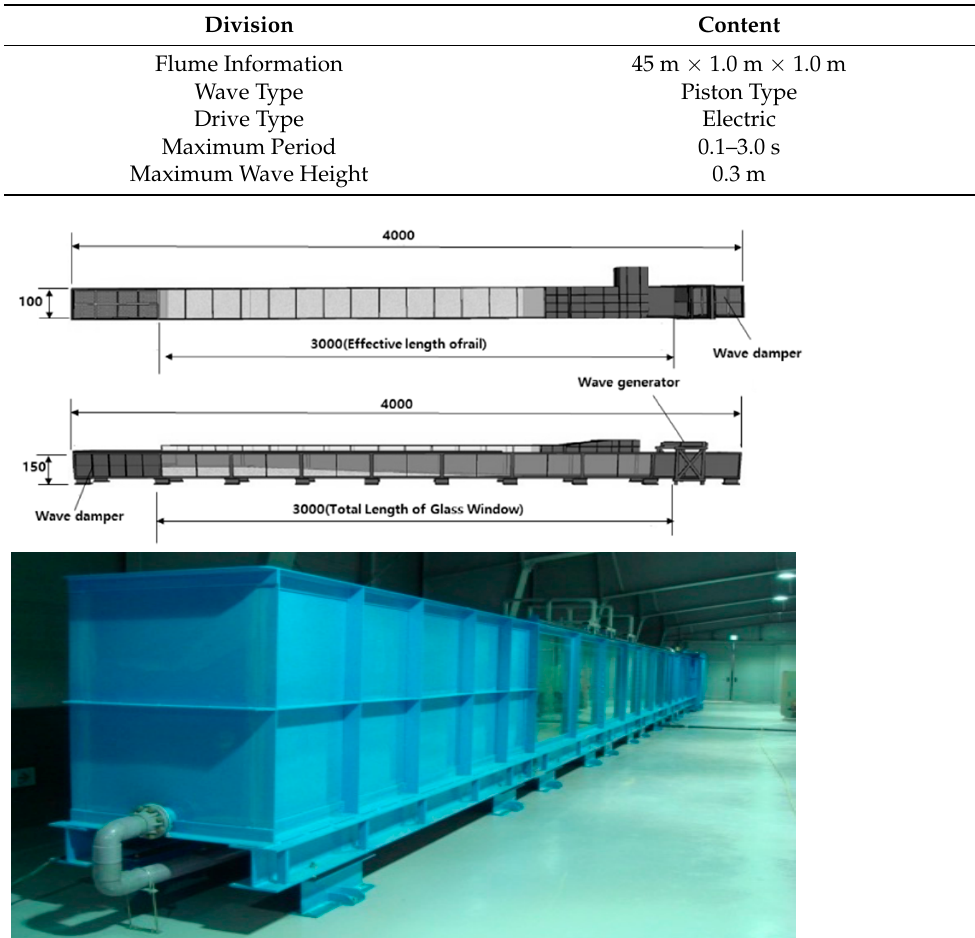
Figure 5. Experiment setup for the two-dimensional cross-sectional wave flume test.